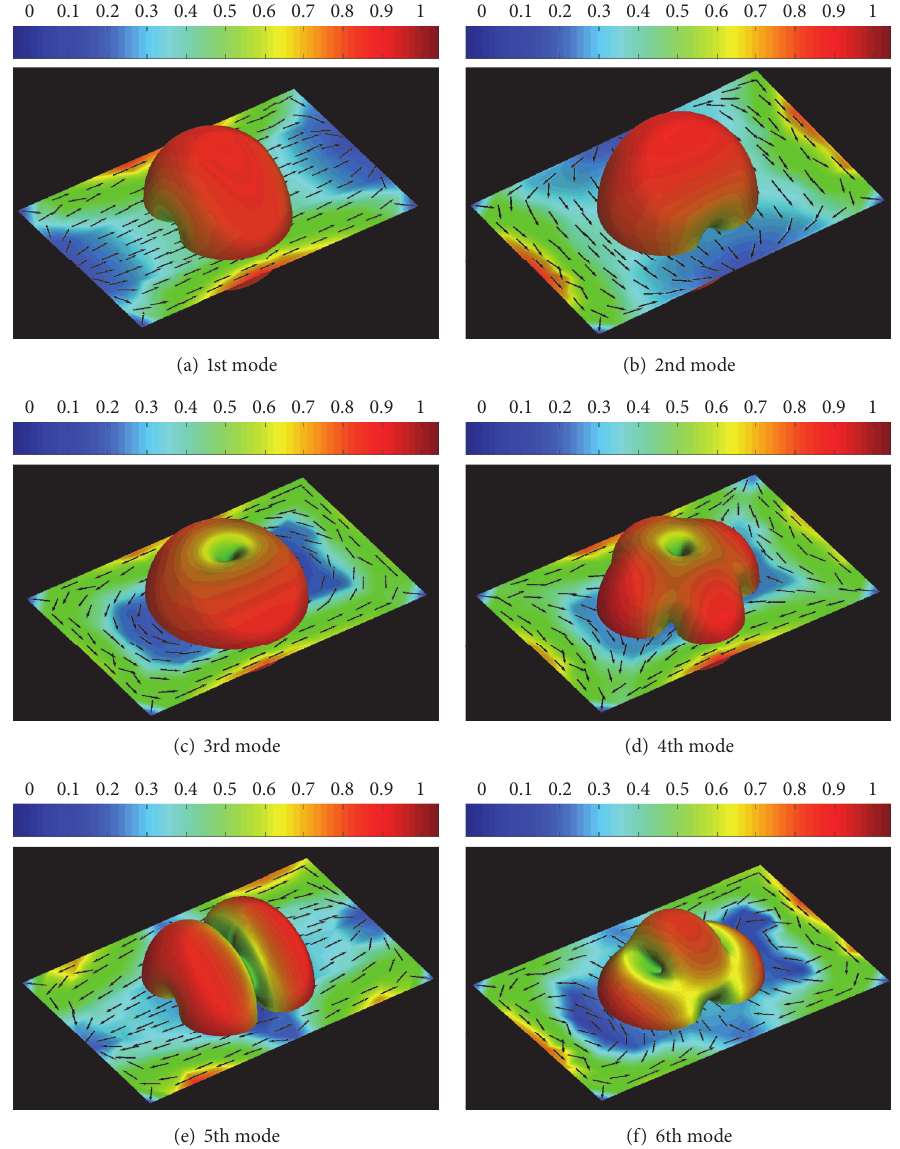
Figure 3: The characteristic currents and fields of the rectangular patch in free